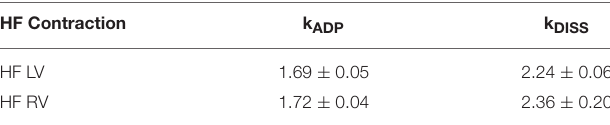
TABLE 1 | Differences between the kinetic rate constants of LV and RV of heart failure